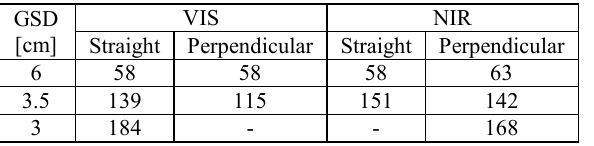
Table 6. Flight GSD, flight line and corresponding image count